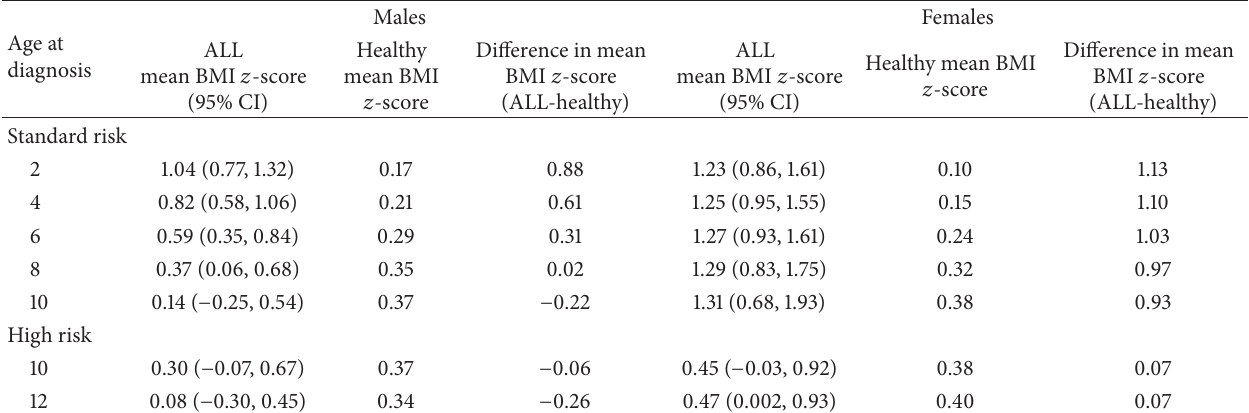
Table 2: Mean BMI 𝑧 -scores at the end of treatment for